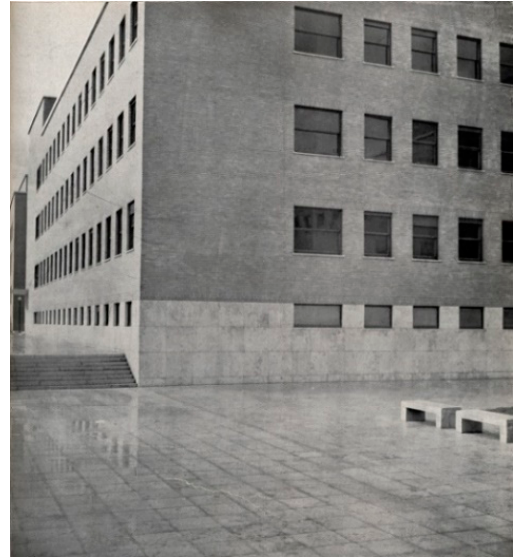
Figure 35. Institute of Physics by Giuseppe Pagano Pogatschnig (1932–1935). Particular of the coating